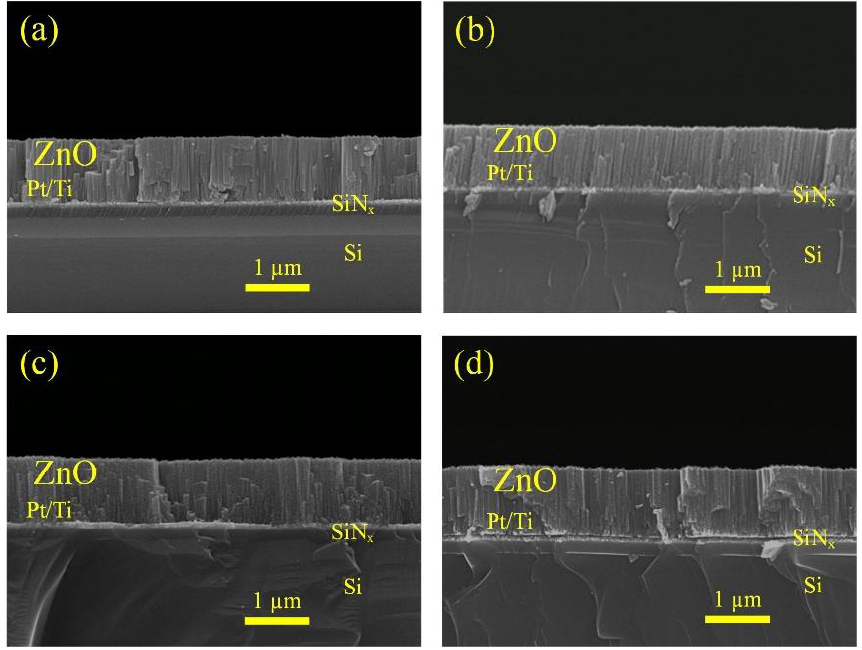
Figure 7. The cross-sectional images of as-deposited ( a ) and RTA treated (( b ) 5 min, ( c ) 10 min and ( d ) 15 min) ZnO thin films at 400 °C.